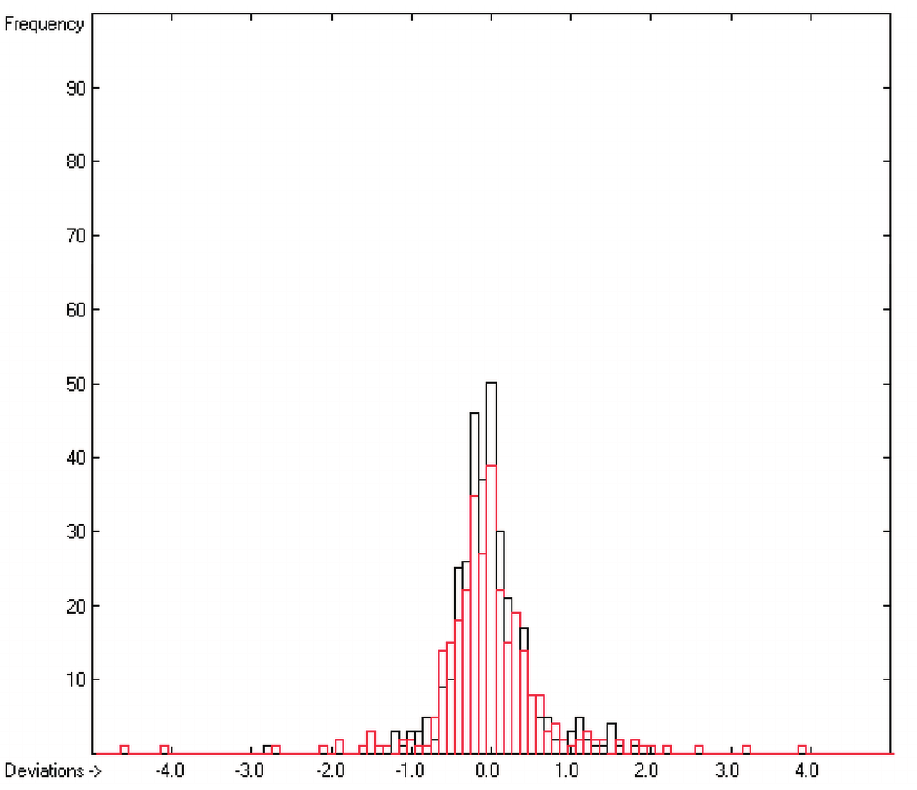
Figure 12. Correlation diagram of polarizability data (10-fold cross-validated: N = 308; Q 2 = 0.9897; slope = 0.99).